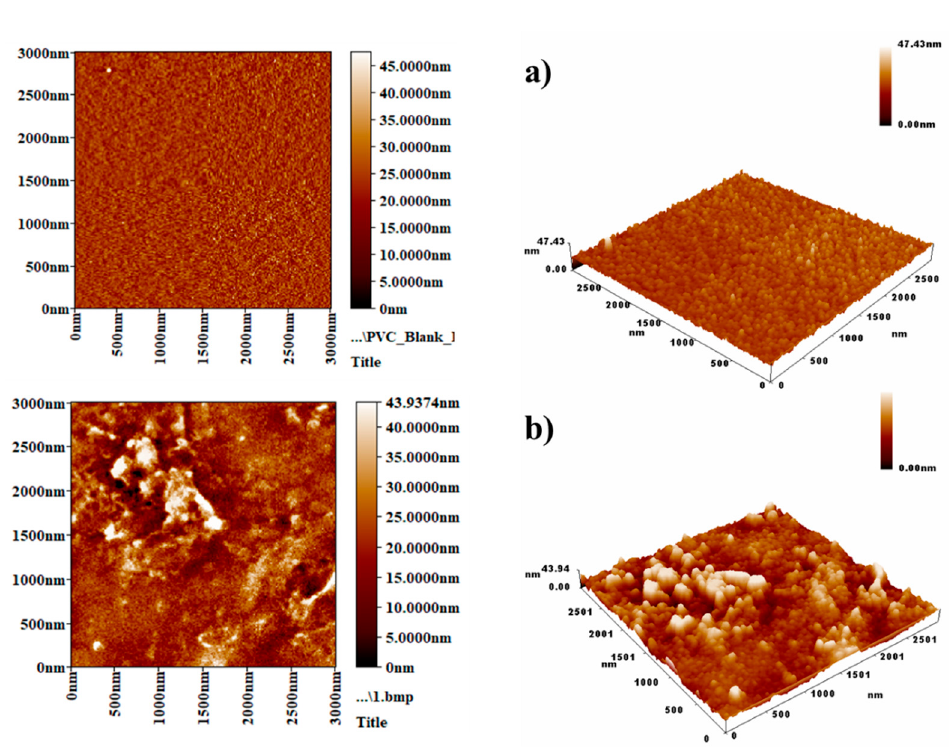
Figure 14. AFM images: ( a ) PVC film without irradiation, ( b ) PVC film after irradiation at 300 h. Table 2. Roughness data for blank and blended PVC films.